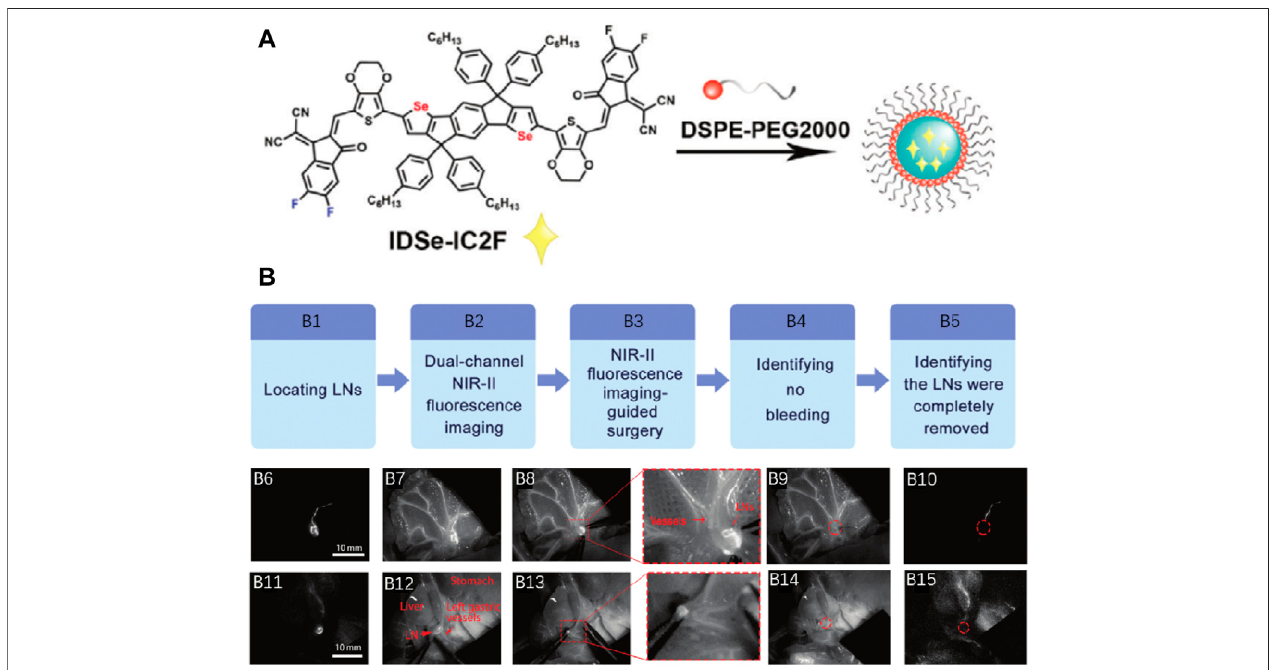
FIGURE9|(A) SchematicillustrationofpreparingIDSe-IC2FNPs. (B) Double-channelNIR-II fl uorescenceimage-guidedlymphadenectomyonrats.Adapted with permission from Fan et al. (2021a).